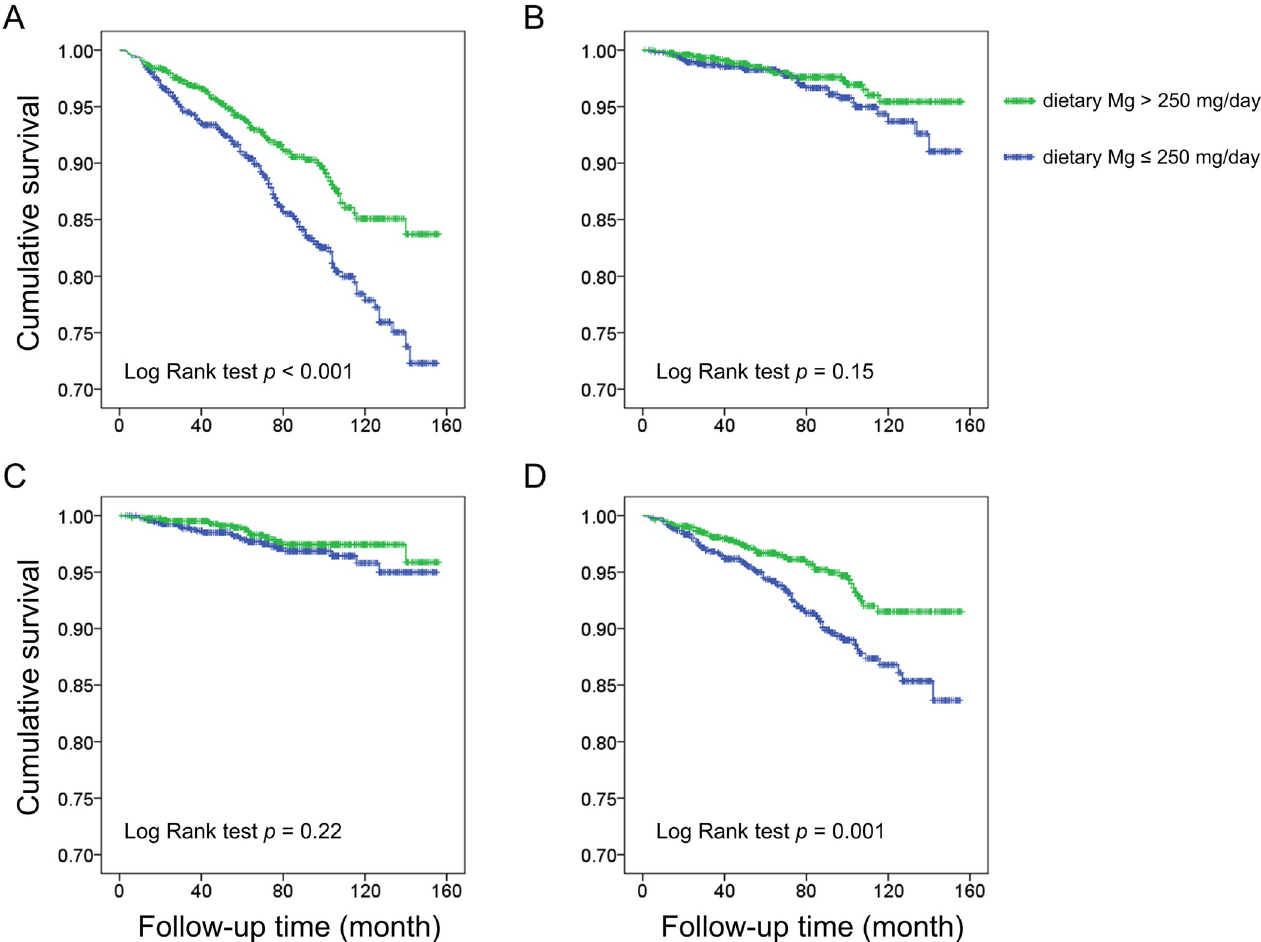
Fig 2. Survival curves for (A) all-cause mortality, (B) cardiovascular disease (CVD) related mortality, (C) cancer related mortality, and (D) other-cause (non- CVD, non-cancer) mortality, by Kaplan-Meier method with Log Rank test. Mg: magnesium.